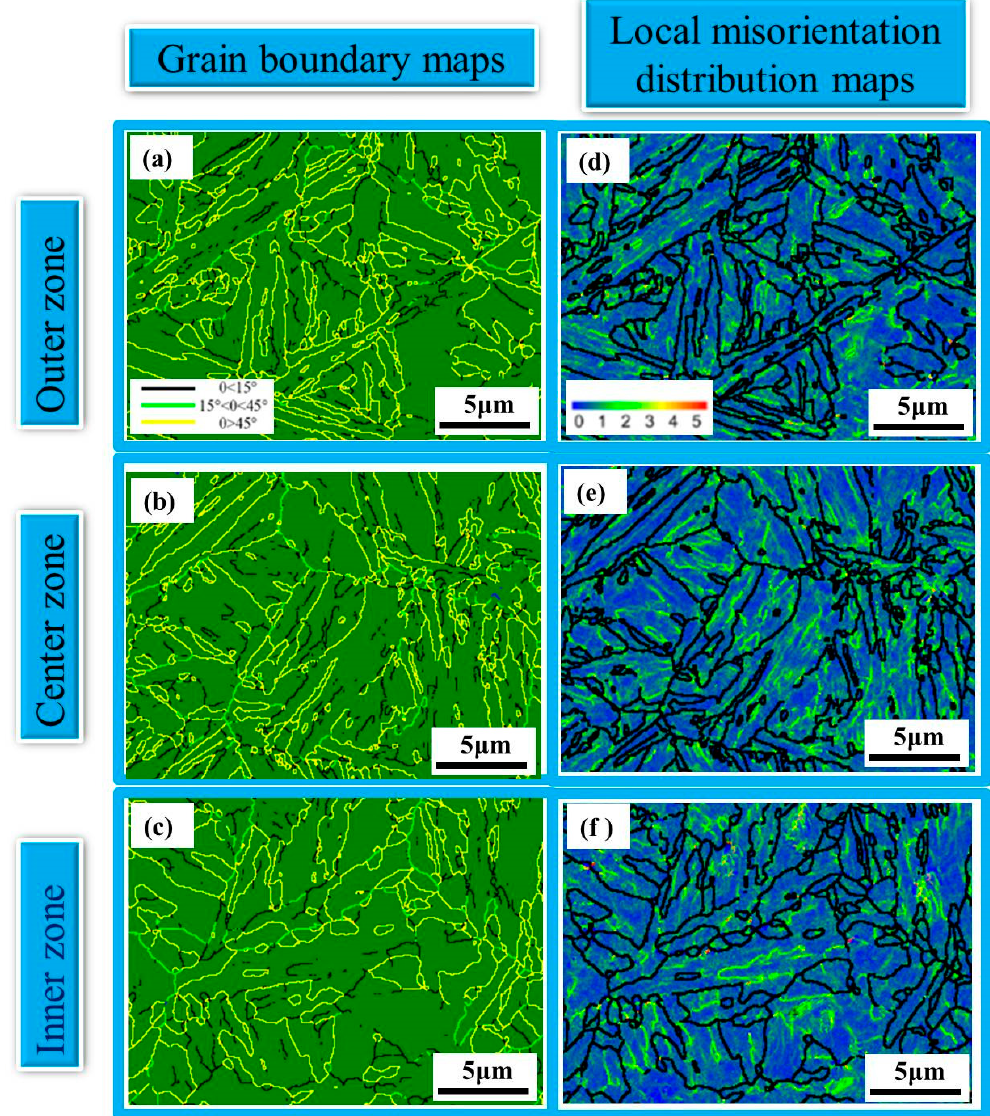
Figure 6. EBSD analysis for outer zone ( a , d ), center zone ( b , e ), and inner zone ( c , f ) of the bending specimen at 104° angle: EBSD grain boundary maps (left), and EBSD local misorientation distribution maps (right).